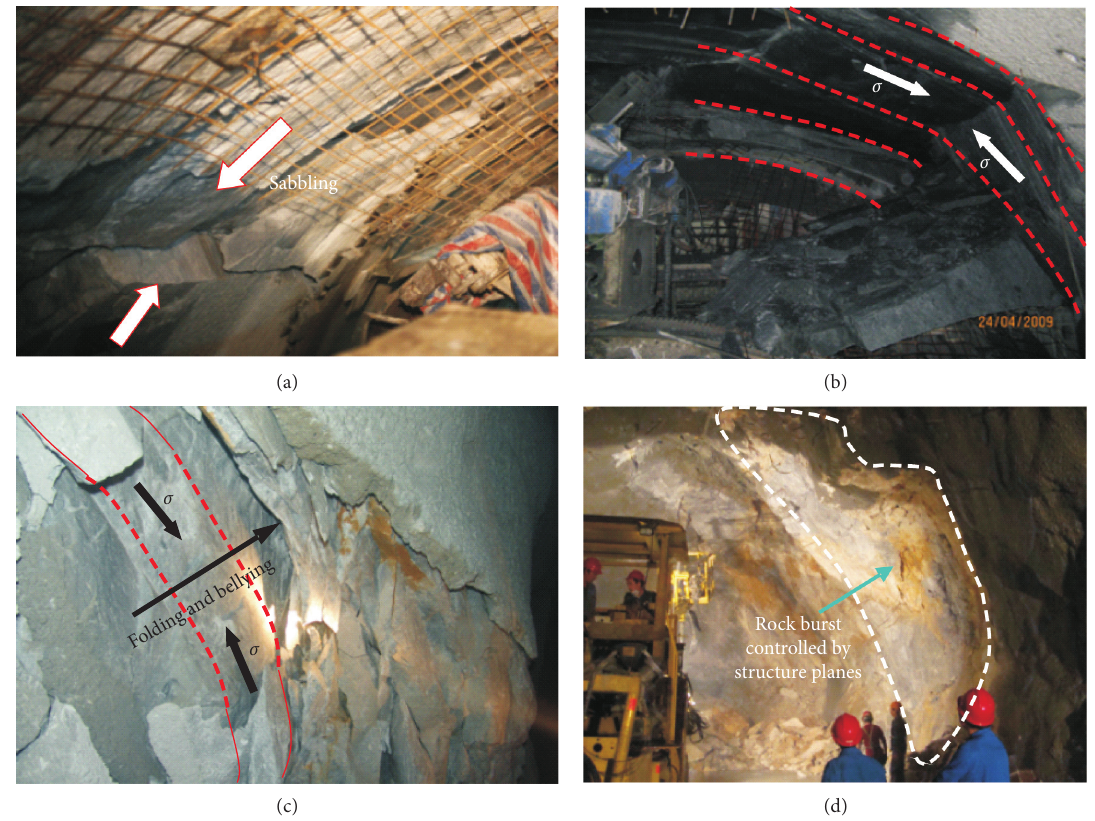
Figure 8: Typical rock burst failures during the excavation process of 1 # ∼ 4 # diversion tunnels: (a) extrusion and slabbing on the left arch foot of 1 # diversion tunnels (section k14 +318 ∼ 328), (b) slabbing caused by stress concentration on the right arch foot of 4 # diversion tunnels (section k13+ 255 ∼ 270), (c) folding and belling on the left sidewall of 1 # diversion tunnels (section k14 +789 ∼ 800), and (d) structure planes controlled failure on the right arch of 2 # diversion tunnels (section k14 +580).